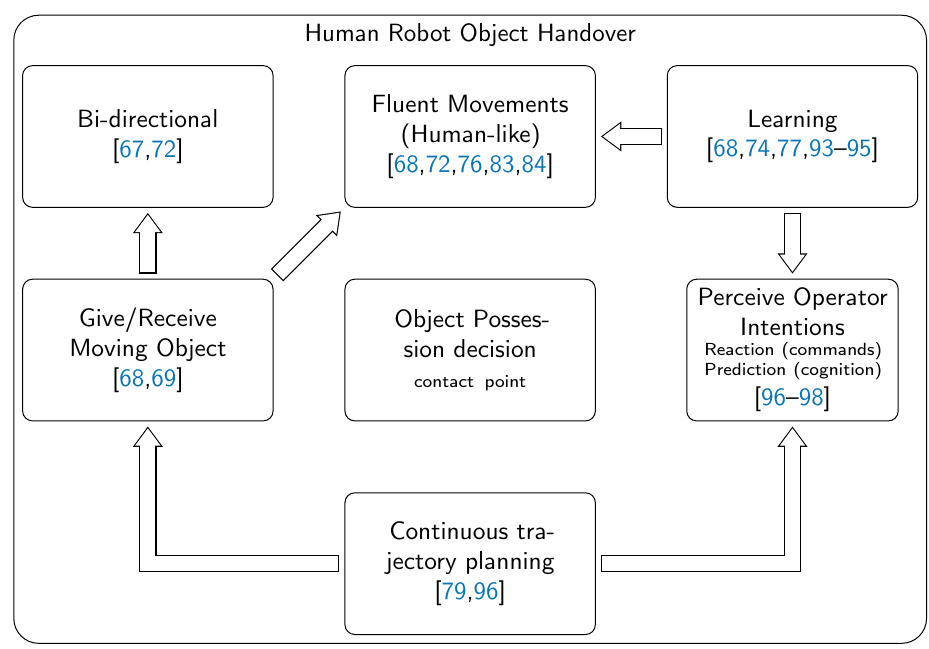
Figure 7. Human-robot object handover challenges